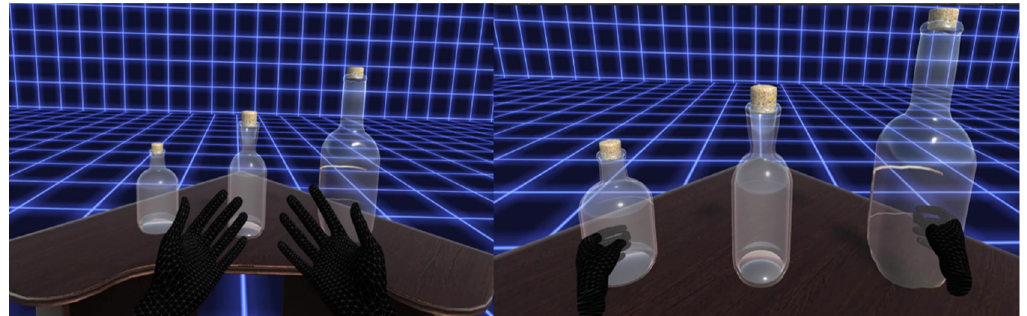
Figure 8. Screenshot of scene from Experiment 2.